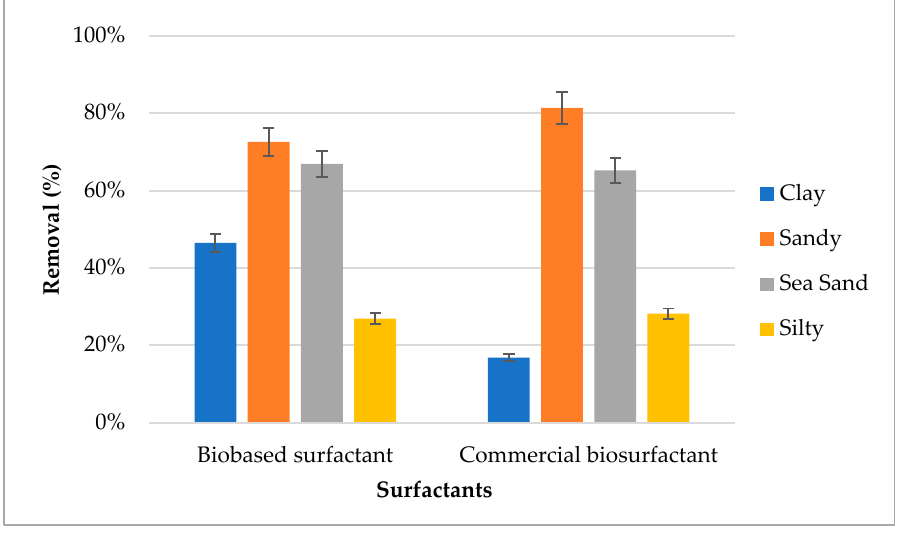
Figure 16. Removal of motor oil adsorbed to four types of soils in SRMS using both the biobased surfactant and the commercial biosurfactant.